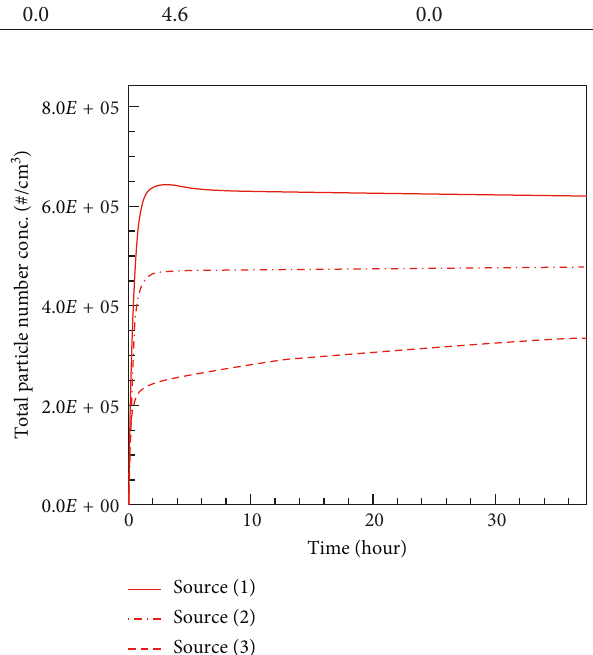
Figure 5: Comparison of total particle number concentration of the SP mode for sources (1–3). The total particle number con- centration of the SP mode is increased with the increase of source